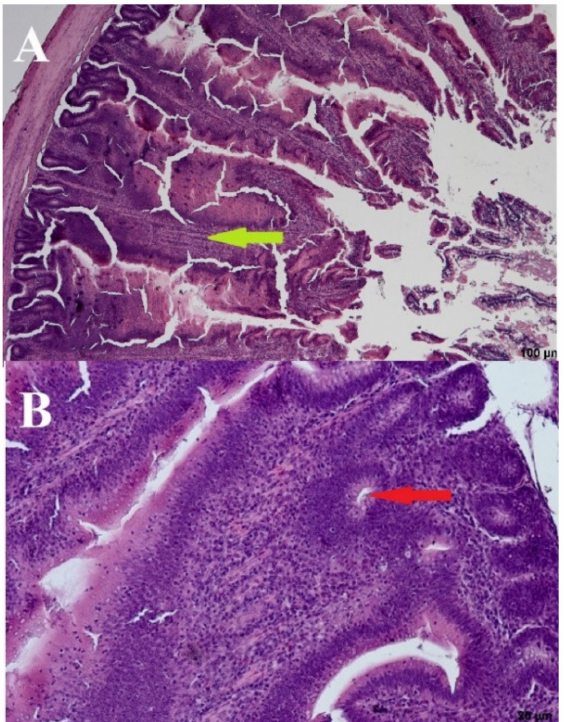
Figure 4. Negative control—( A ) Cross section through the intestine—100 µ m and ( B ) crypts—20 µ m. Arrows: bold green–villi,